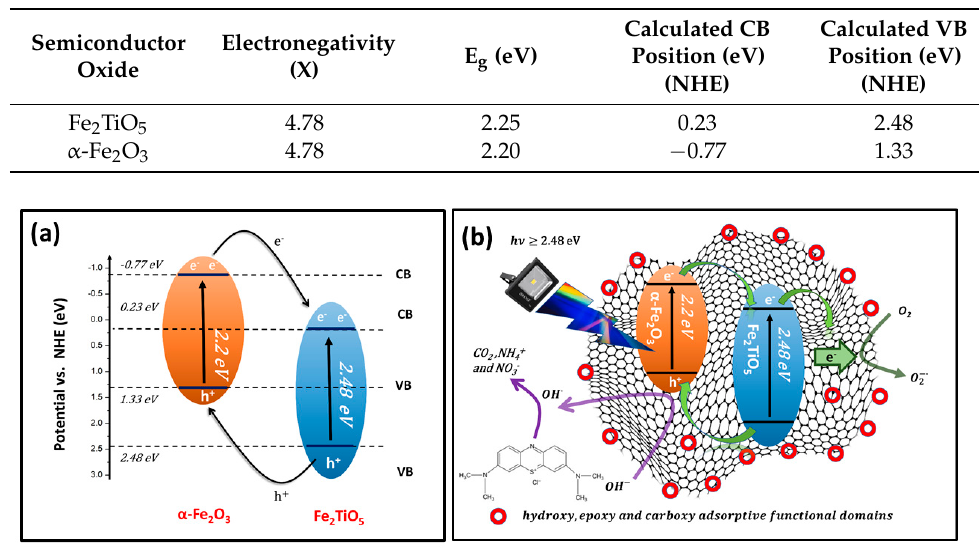
Table 7. Parameters behind the calculation of VB and CB energy.